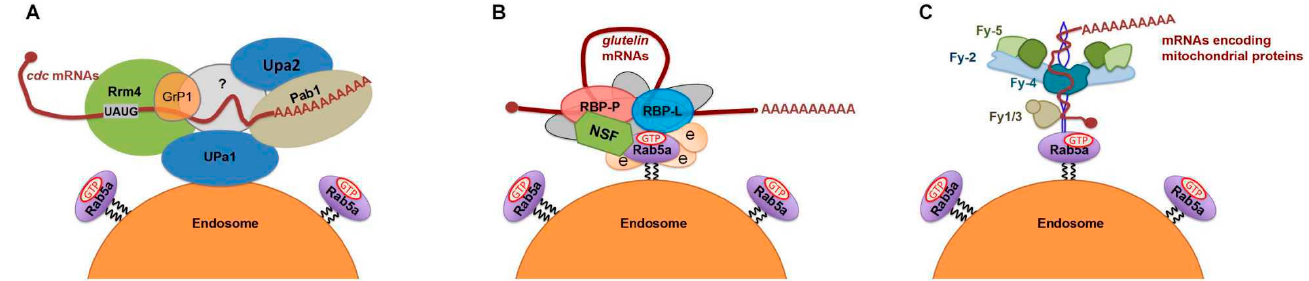
Figure 6. Proposed models of endosome-coupled trafficking of mRNAs in different organisms. ( A ) Working model of cdc mRNA transport via trafficking endosomes in the fungus U. maydis (adapted from [64]). The mRNAs encoding four septins, Cdc3, 10, 11 and 12, are bound by Rrm4 and Pab1, which recruit GrP1, UPa1, and UPa2 as well as an unknown linker protein (grey color). The resulting mRNP complex is associated with a trafficking endosome through membrane protein UPa1. ( B ) Working model of glutelin mRNA transport via trafficking endosomes in rice endosperm cells (adapted from [65]). Glutelin mRNAs are recognized and bound by RBP-P and RBP-L, forming an mRNP complex. Through direct or NSF-mediated interaction of RBP-L and RBP-P, respectively, with key endosomal factor, Rab5a, the quaternary complex links the mRNP complex onto endosomes for active transport via the cytoskeleton. Other unknown RBPs or factors (light gray) may also be involved to stabilize the mRNP complex and define the connection to endosomes. ( C ) Working model of the transport of mRNAs encoding mitochondrial proteins via trafficking endosomes in rat neuron cell (adapted from preprint studies of [66,67]). A FERRY (Five-subunit Endosomal Rab5 and RNA/ribosome intermediary) complex, composed of Fy-1 to 5, is required for transport. Fy-2 directly binds to mRNAs through its coiled-coils and recruits Fy4 and Fy-5 to form a clamp-like structure. Although Fy-1 and Fy-3 are not required for RNA binding, they assist Fy-2 to adopt the correct folding and conformation. In addition to functioning as the main binding protein to mRNAs, Fy-2 also interacts with the GTP-bound form of Rab5 via its C-terminal region, linking the mRNP complex onto trafficking endosomes for active mRNA transport.